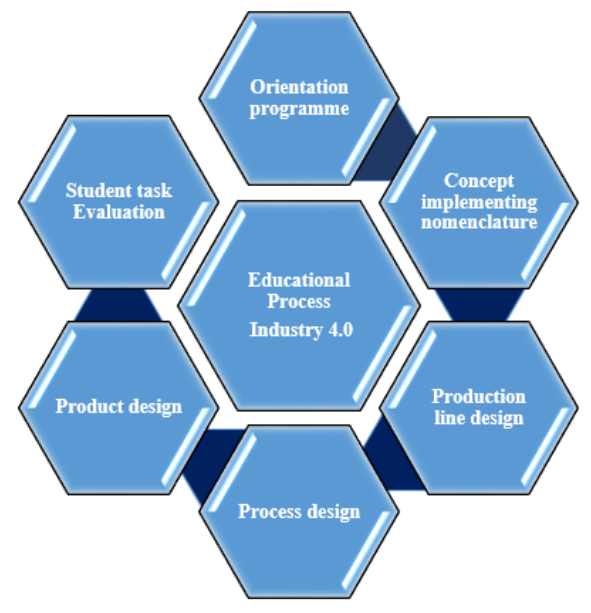
Figure 1. Educational process.